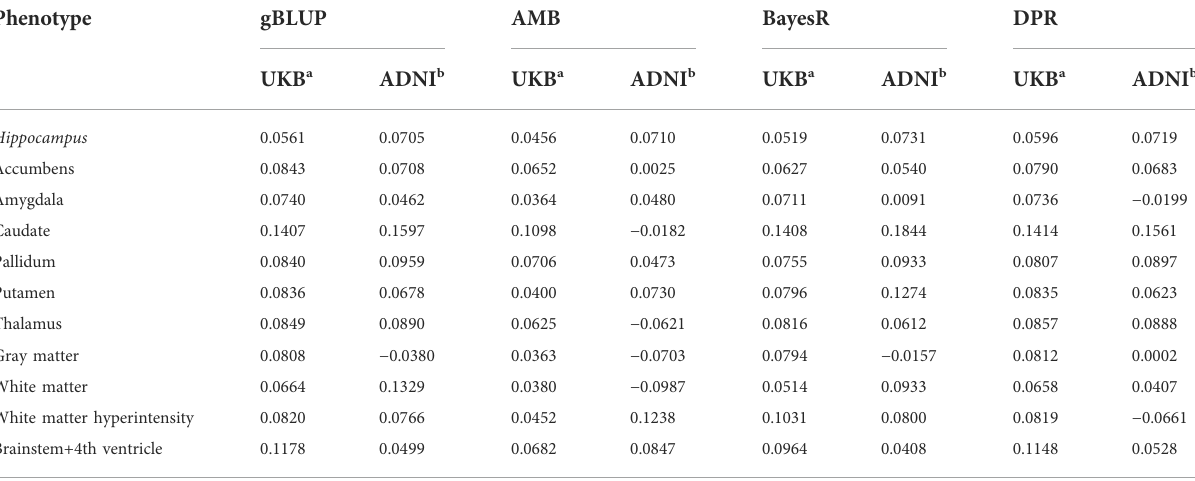
TABLE 3 The Pearson correlation for cross-validation and external validation for eleven brain imaging traits that are predicted using genetic variants